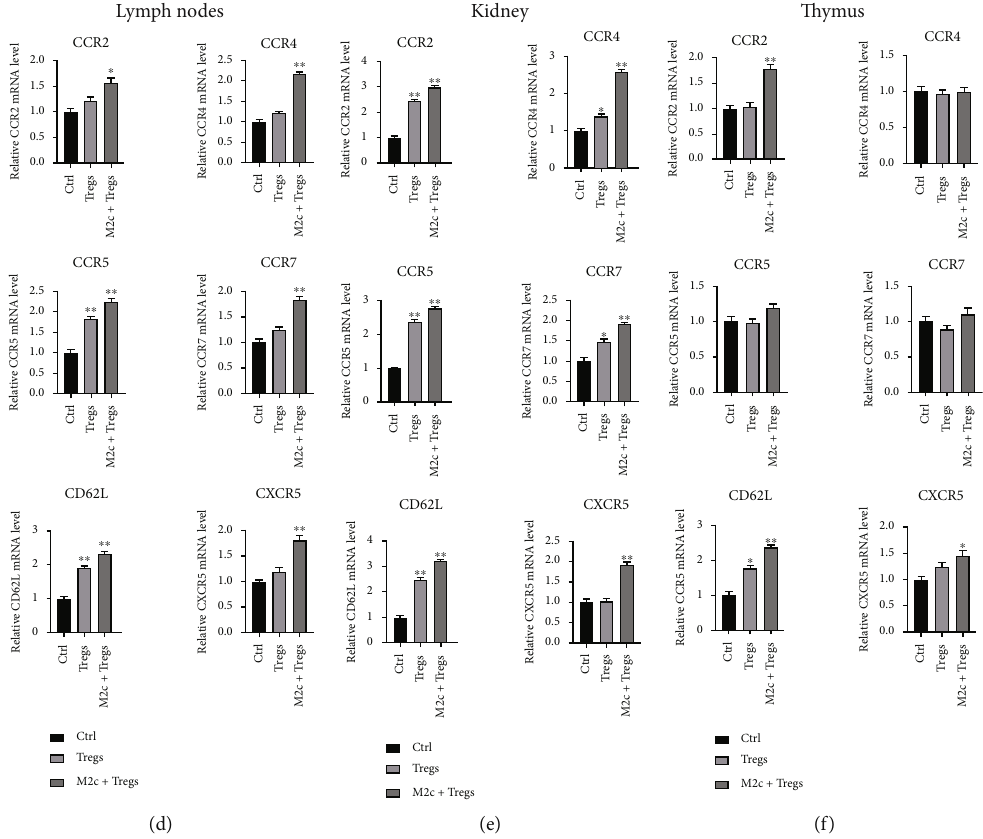
Figure 3: Quantitative reverse transcription-PCR (qRT-PCR) experiments con fi rmed that M2c macrophages promote the migration of Tregs via chemokines and their receptors. (a) Comparison of chemokine receptor expression between the Tregs-treated group and M2c macrophages+Tregs treatment group, based on qRT-PCR. (b – f) Chemokine receptor expression in the blood, spleen tissue, renal draining lymph nodes, kidney tissue, and thymus tissue from mice of normal control group, Tregs-treated group, and M2c macrophage +Tregs treatment group was compared based on explore how M2c macrophages regulate Tregs, we cultured mouse peritoneal M2c macrophages and thymic Tregs (Figure S1A) and fl uorescently labeled them using recombinant lentivirus (Figure S1B). Then, we cocultured the two cell types and measured the levels of several chemokine receptors that regulate the migration and homing of Tregs. The expression of chemokine receptors varied between Tregs monocultures and M2c macrophage+Tregs cocul- tures. Among the analyzed chemokine receptors and adhe- sion molecules, CCR2, CCR3, CCR4, CCR5, CCR7, CCR8, CCR10, CXCR3, CXCR5, and CD62L were signi fi cantly upregulated in cocultures, particularly CCR2, CCR4, CCR5, CCR7, CXCR5, and CD62L (Figure 3(a)). M2c mac- rophages may act through these cytokines to promote the migration of Tregs.